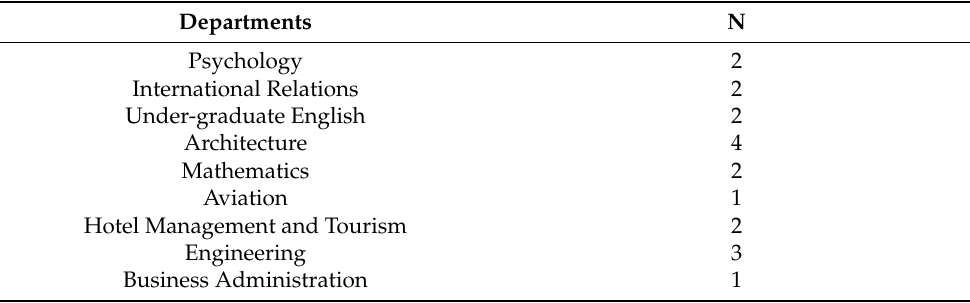
Table 1. Informants of teacher interviews on consequential